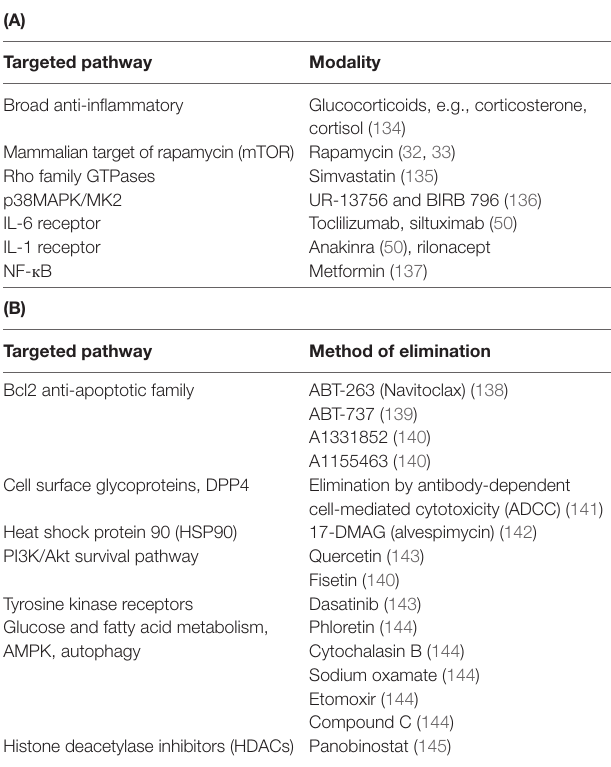
TABLe 1 | Potential anti-senescence-associated secretory phenotype (SASP) and senolytic